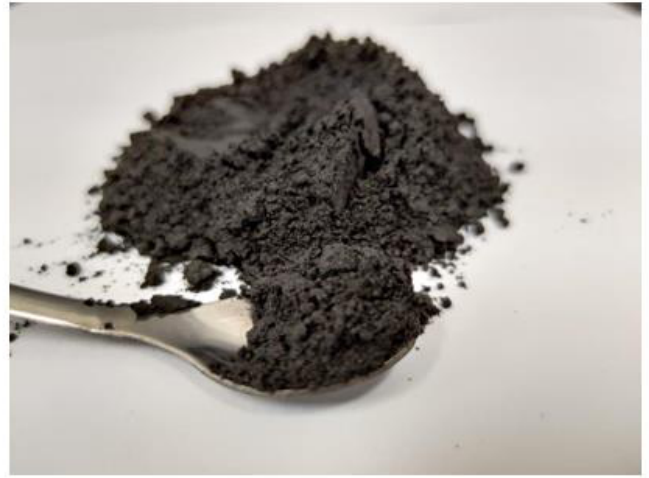
Figure A1. Demonstration of the charcoal fines produced.